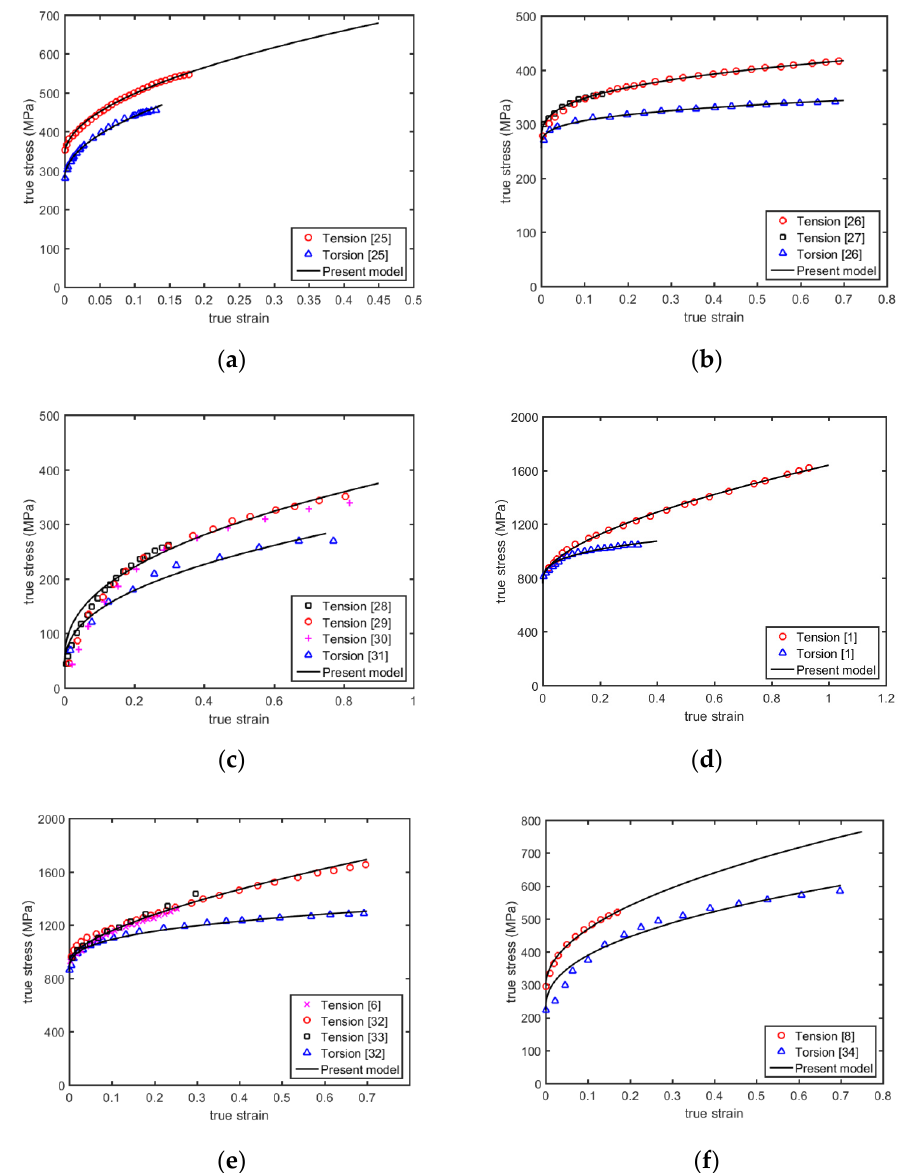
Figure 1. Comparison of the present model with the true stress-true strain curves obtained from tension and torsion tests. ( a ) 2024-T351 Al; ( b ) 6061-T6 Al; ( c ) OFHC copper; ( d ) 4340 steel; ( e ) Ti-6Al-4V alloys; ( f ) Q235 mild steel.